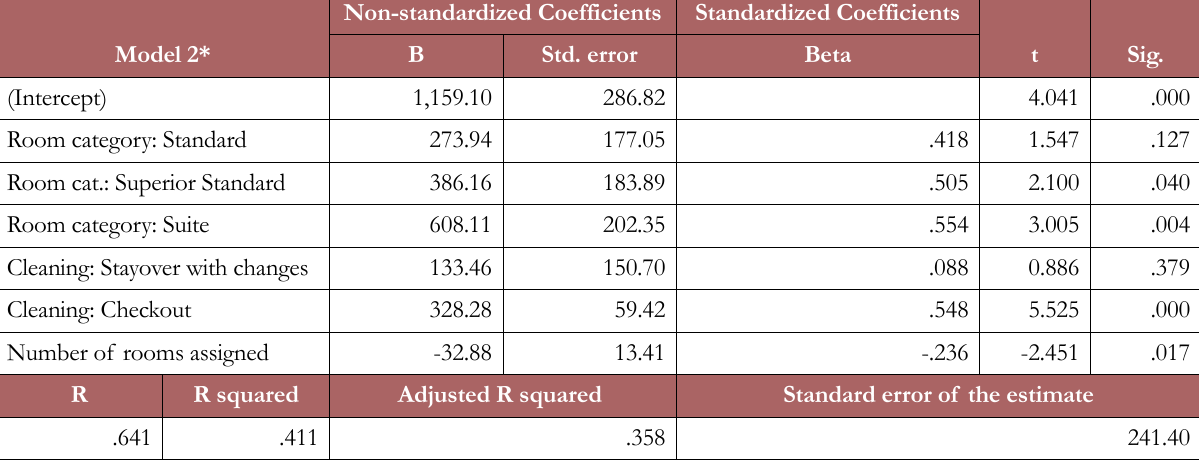
Table 7. Model 2. Linear regression analysis with the cleaning task-related